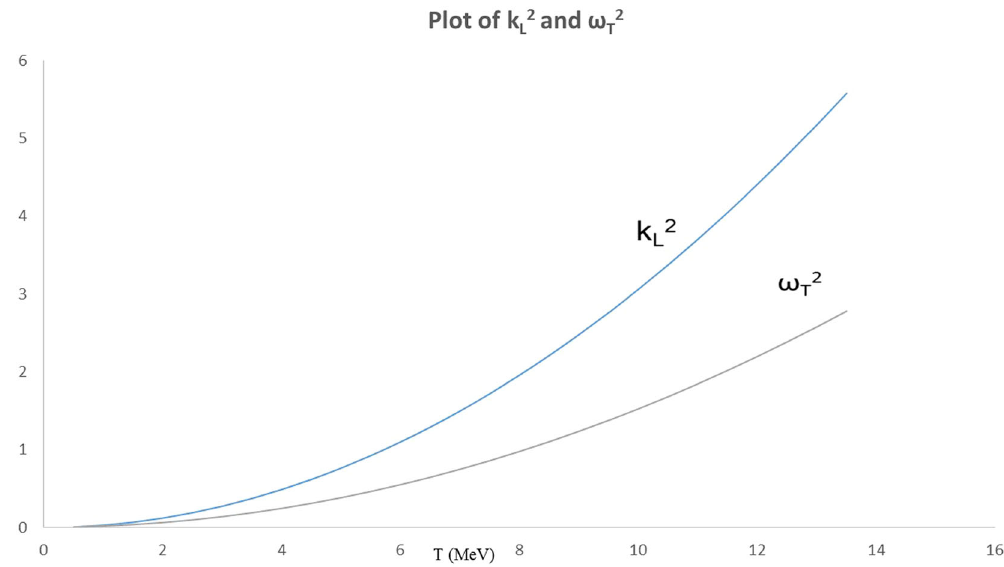
Fig. 1 Temperature dependence of the longitudinal component of the propagation vector (square) and the transverse frequency (square) is plotted showing that the Debye shielding length is greater than the plasma frequency